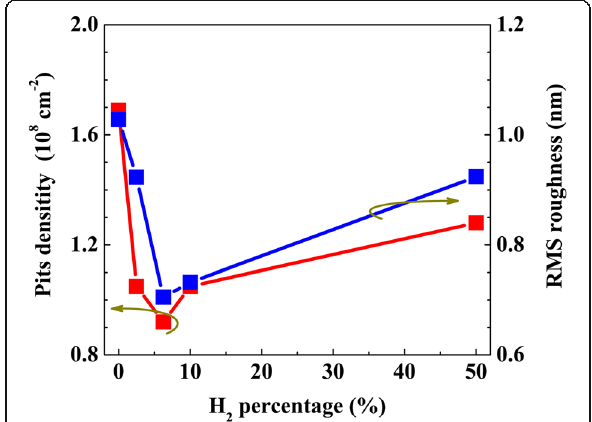
Fig. 3 The variation trend of pits density and RMS surface roughness under different H 2 percentage in carrier gas during the growth of barriers